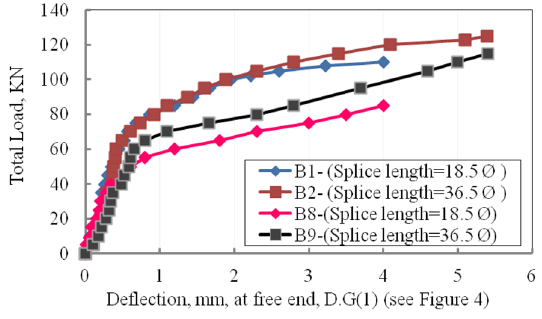
Fig. 18 Load–deflection curves for B1, B2, B8 and B9